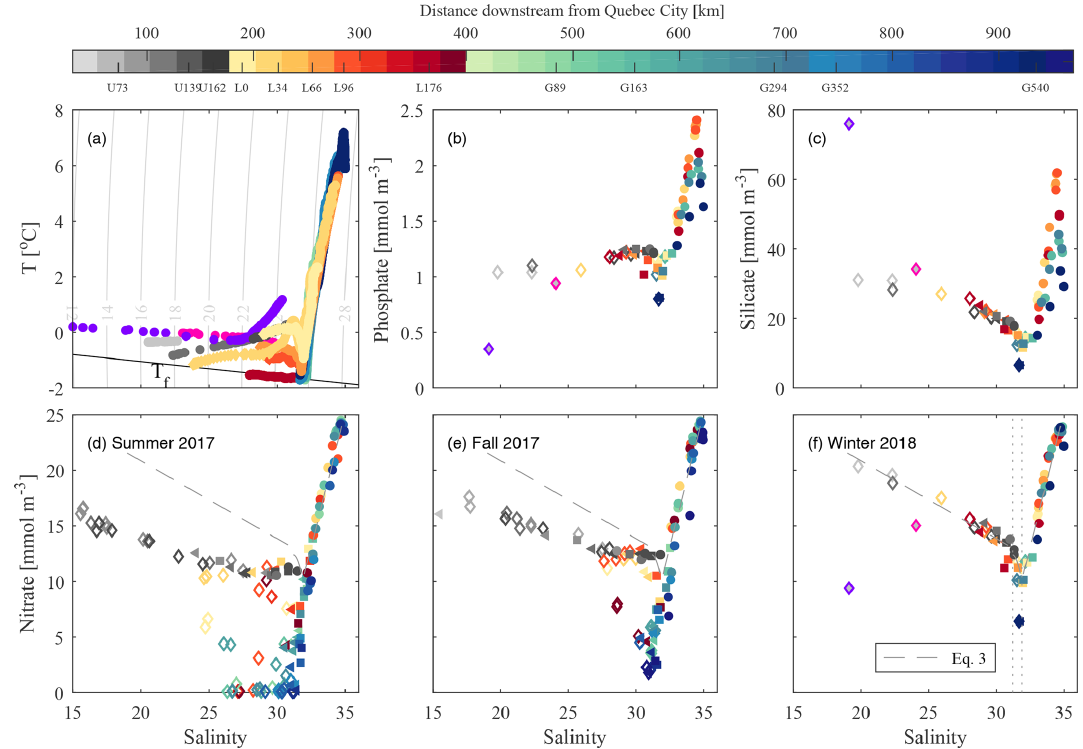
Figure 4. Winter 2018 observations of (a) potential temperature (at atmospheric pressure), (b) phosphate, and (c) silicate illustrated against salinity. The nitrate concentrations for (d) the summer 2017, (e) fall 2017, and (f) winter 2018 are also shown. The symbols in panels (b) – (f) indicate the sample’s depth. The open diamonds are near the surface (depth < 20m), while the closed triangles and squares are samples at 25 and 50m, respectively. The closed circles represent deeper samples at or below 100m. The two vertical dotted lines in (f) denote salinities of 31.2 and 31.9. Density contours in σ T [kgm − 3 ] (a) were computed at atmospheric pressure. Concentrations measured from the most upstream station U37 were 26.43mmolm − 3 for nitrate, 0.53mmolm − 3 for phosphate, and 39.8mmolm − 3 for silicate. This bottle at 10m of depth corresponded to salinity of ≈ 0 . 5. T f is the freezing temperature of seawater in (a)